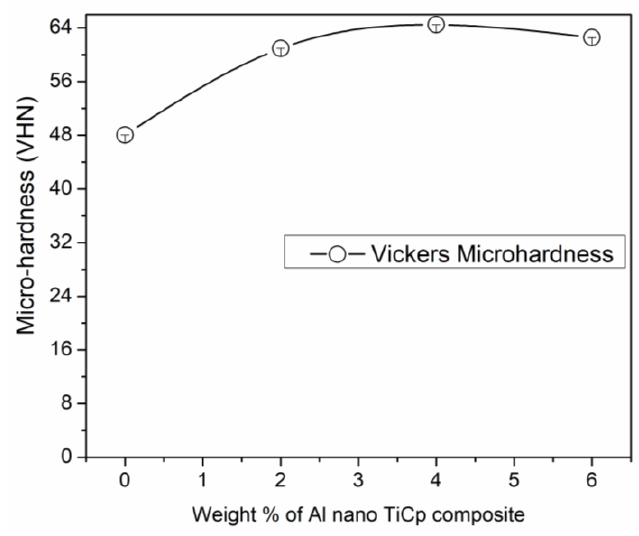
Figure 4. Vickers micro-hardness of Al nanoTiC p composites.